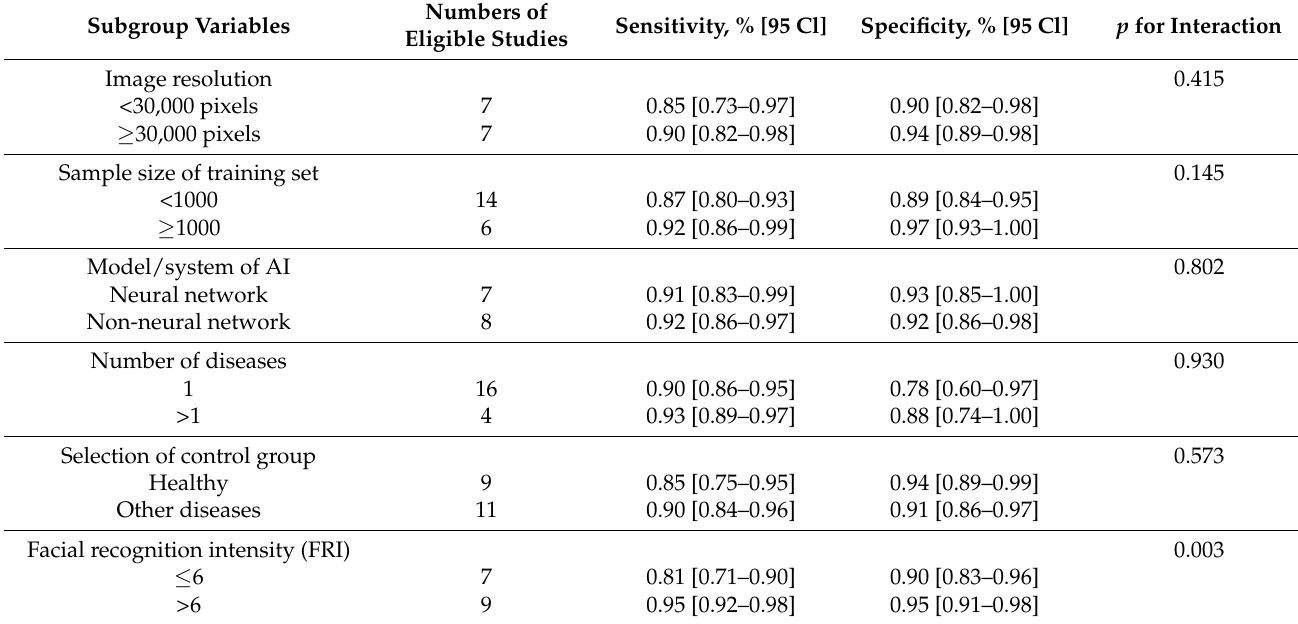
Table 5. Subgroup analyses for the accuracy of automatic diagnosis by facial recognition. Image resolution was calculated by multiplying column pixels by row pixels. If images of different resolution were used, the average resolution was calculated. The two-tailed probability of type I error was 0.05 ( α =